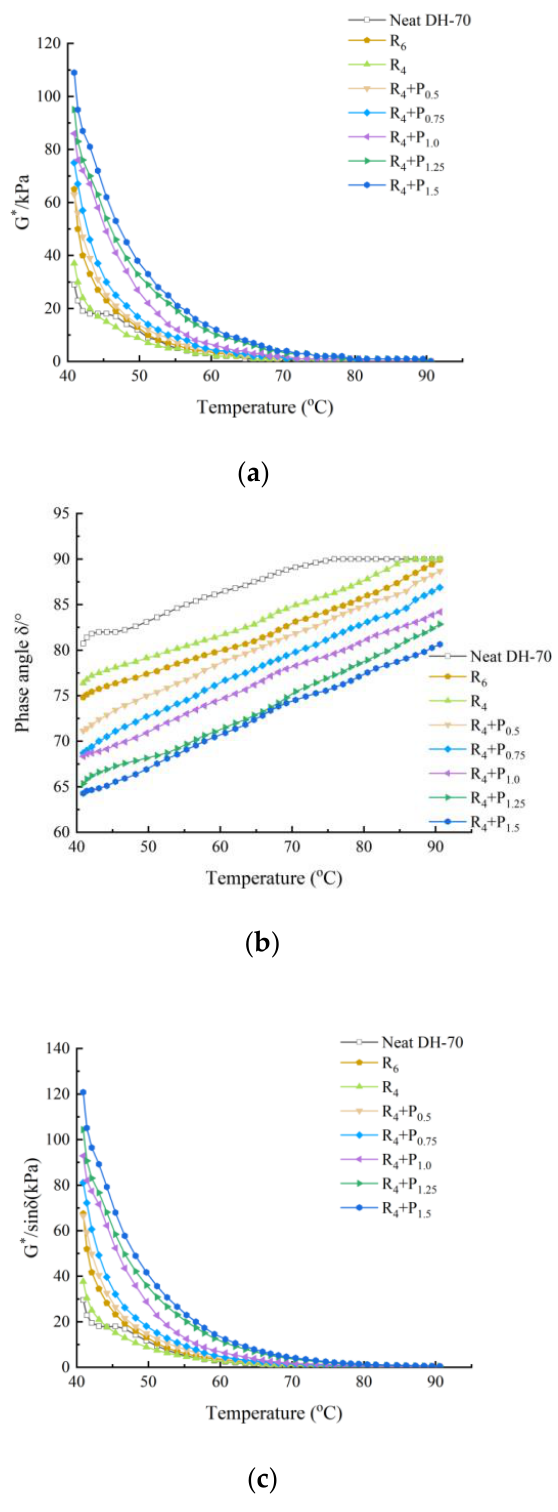
Figure 3. High-temperature properties of compound ratio of PPA – SBR and DH – 70# neat asphalt: ( a ) Complex modulus-temperature results; ( b ) Phase angle-temperature results; ( c ) G*/sinδ -tenperature results.